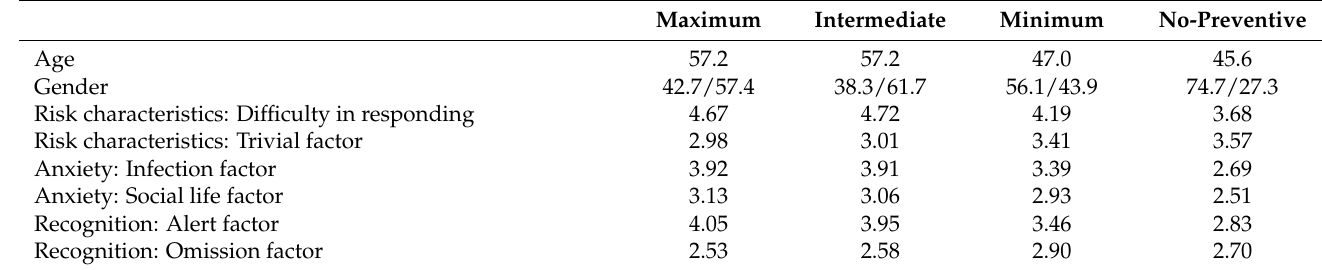
Table 8. Characteristics of the four preventive groups